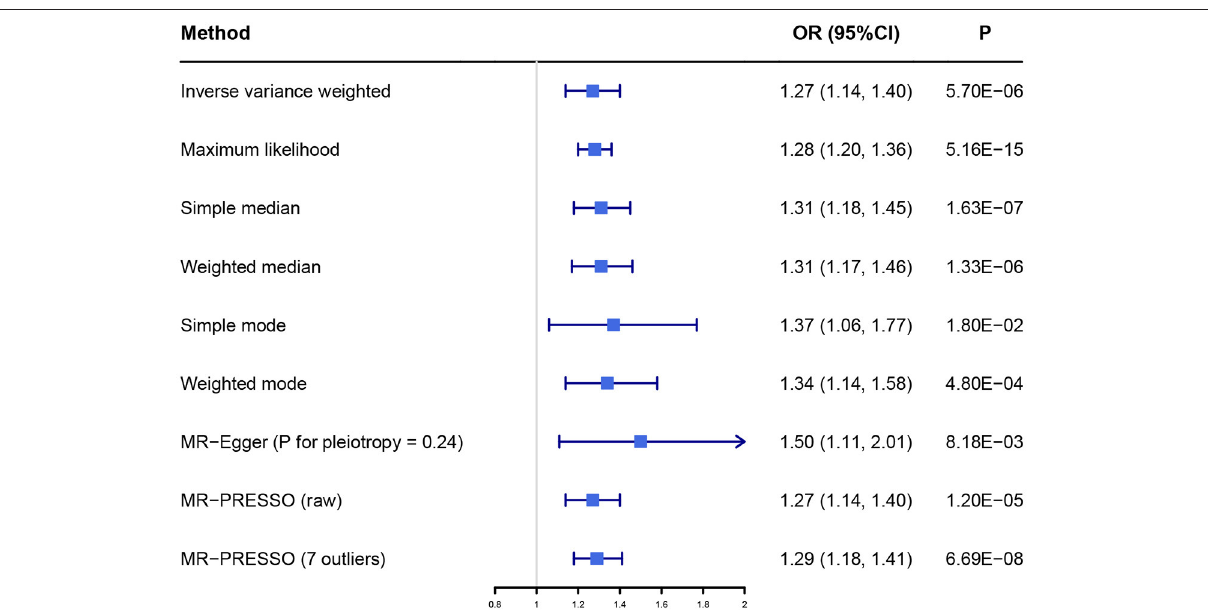
Frontiers in Cardiovascular Medicine |